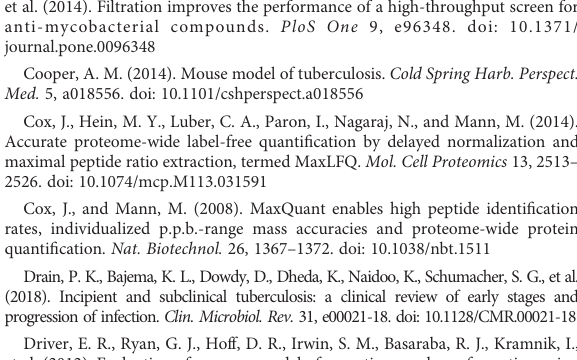
SUPPLEMENTARY TABLE 3 The core enrichment genes related to fatty acid metabolism, oxidative phosphorylation and mTOR signaling for GSEA.